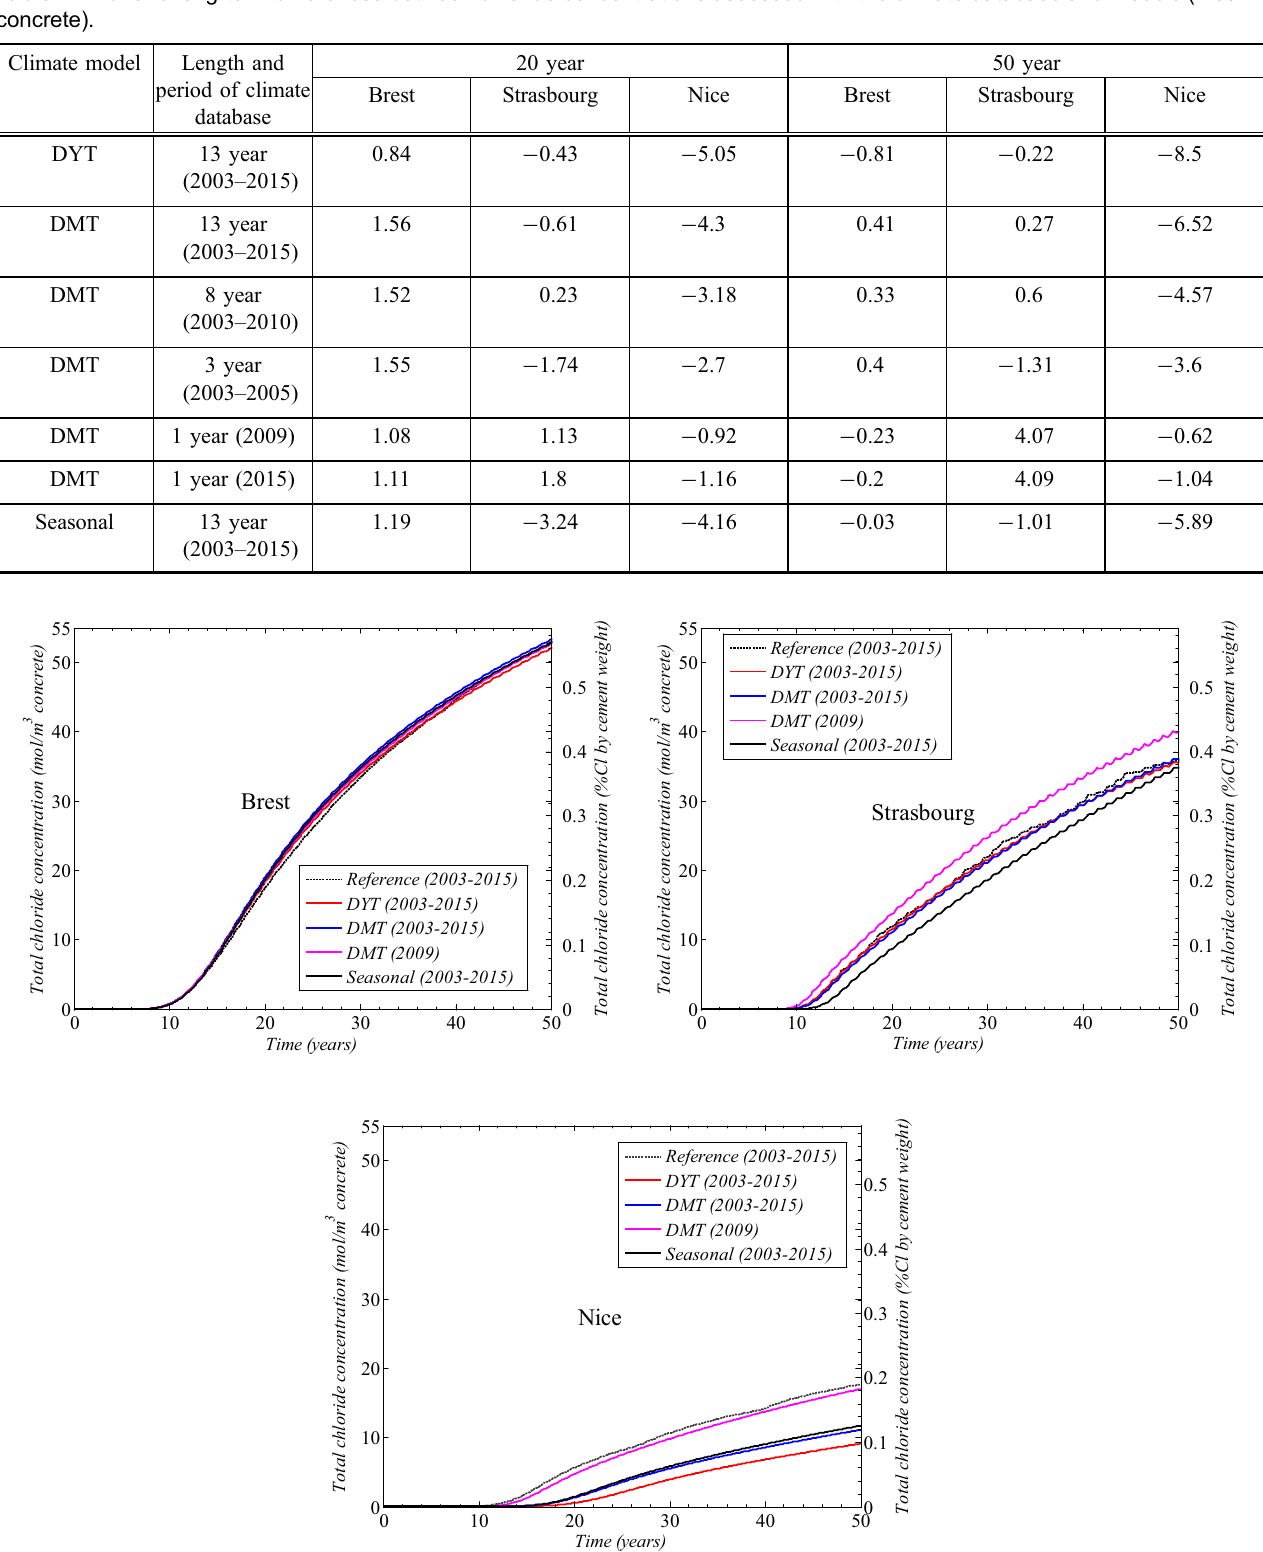
Fig. 12 Evolution of total chloride concentration at the cover depth for climate database and